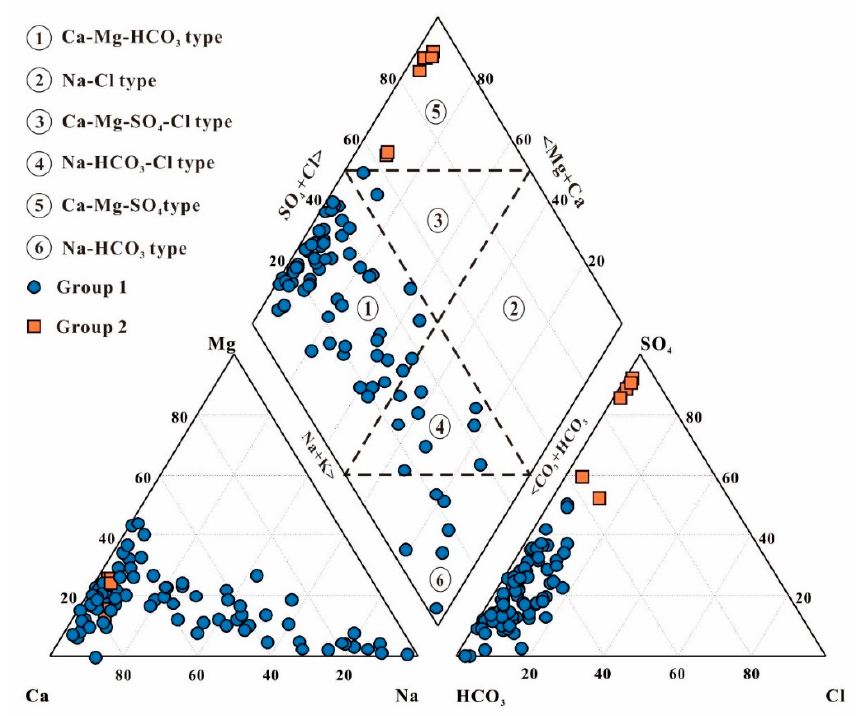
Figure 4. Piper trilinear diagram for groundwater samples.